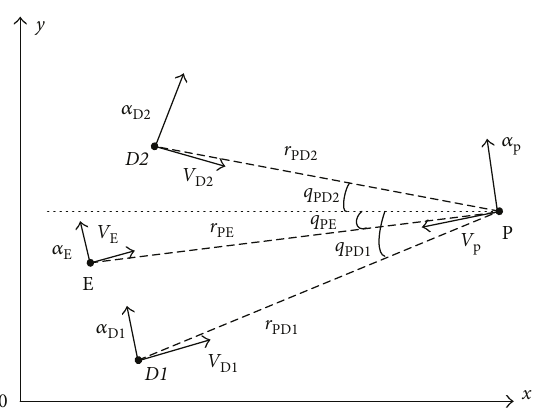
Figure 2: Schematic planar geometry of the four-aircraft